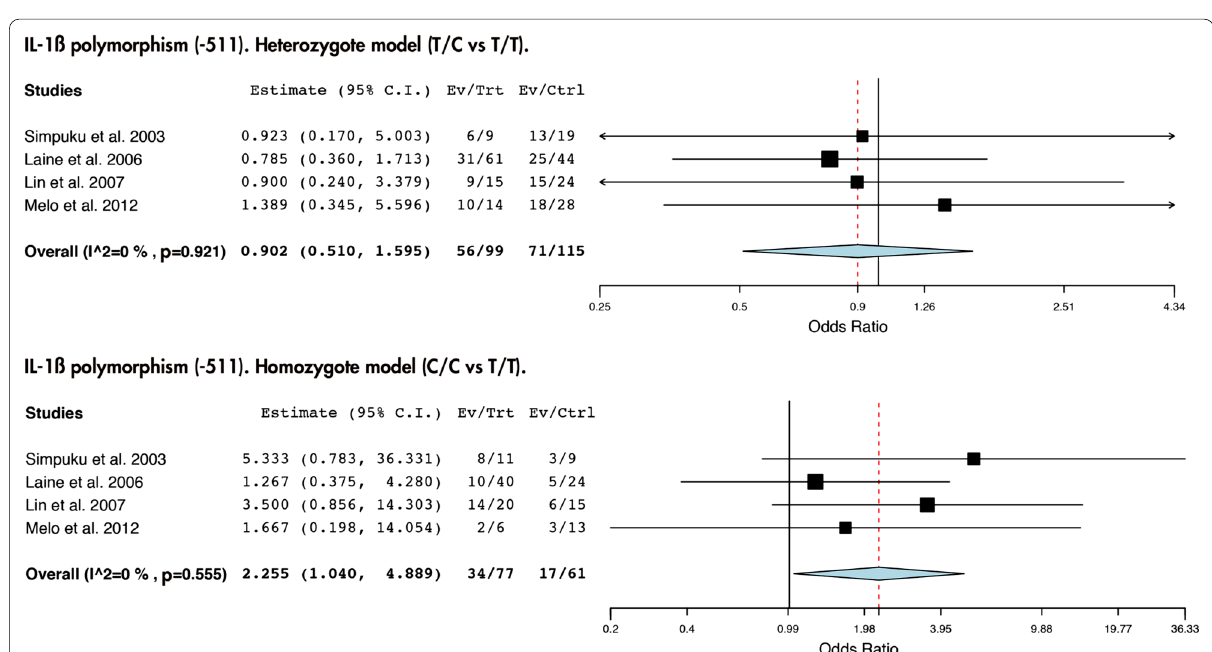
Fig. 4 Association between IL‑1β ( 511) polymorphism and peri‑implantitis in the heterozygote and homozygote −